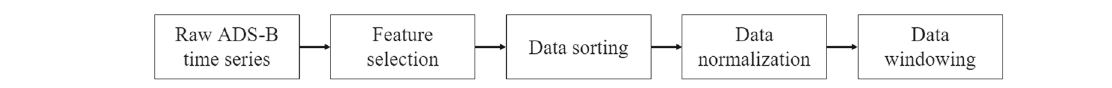
can monitor air traffic by receiving this information. The ADS-B protocol format is shown in Fig. 1.